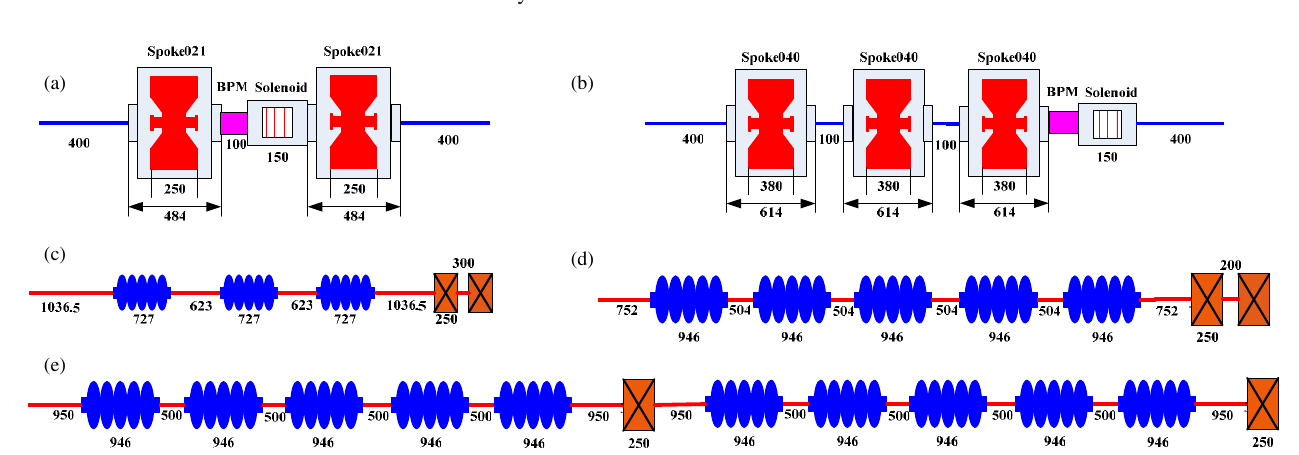
FIG. 5. Lattice structures of the main linac (a: Spoke021 section – RSR; b: Spoke040 section – R 3 S; c: Ellip063 section – R 3 FD; d: Ellip082 – R 5 FD,; e: Ellip082 – R 5 FR 5 D; S for SC solenoids, R for SC resonators, F = D for warm quadrupoles).